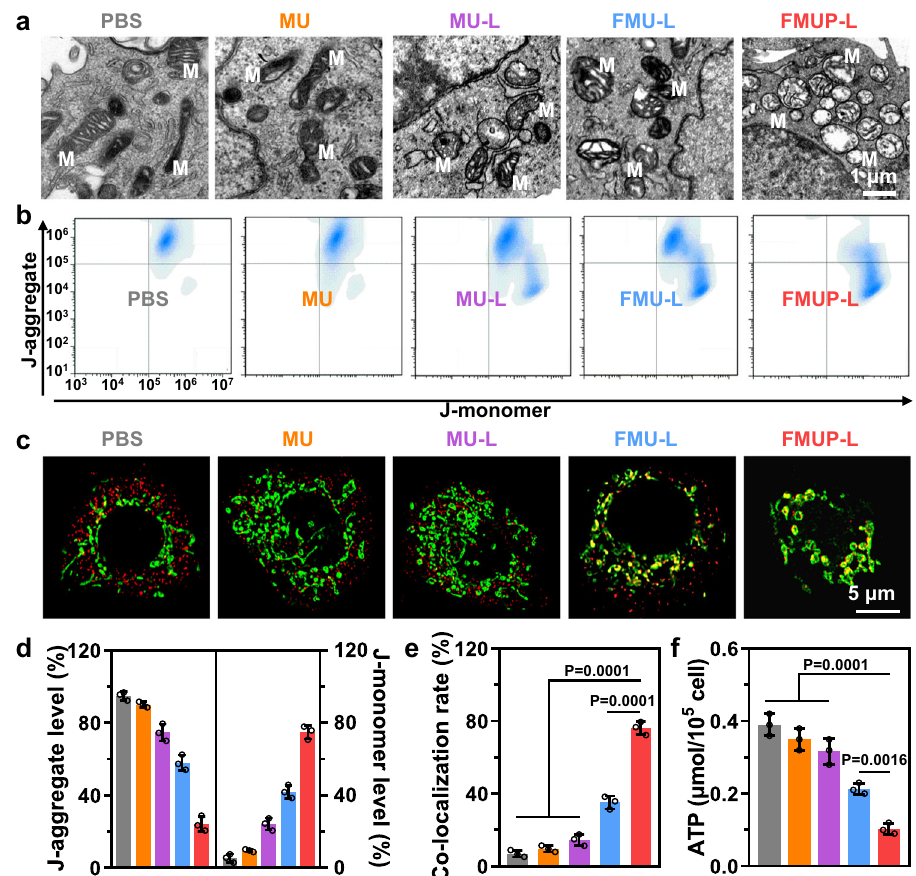
Fig. 4 In vitro evaluation of mitochondrial damage by the synergism of CDT and photoacidi fi cation. a TEM ultrathin sectioning images of mitochondrial integrity in different groups. M in images represents the mitochondria. b Mitochondrial membrane potential analysis of HeLa cells treated with different groups by using fl ow cytometry. c CLSM images of cyclophilin D (Cyp D) expression in HeLa cells with different groups. Green: mitochondria; Red: Cyp D. d Quantitative analysis of J-aggregate and J-monomer in various treatments. e The co-localization rate of nanoagents with mitochondria in different groups. f Quantitative analysis of intracellular ATP concentration in various treatments. Data in ( d – f ) were represented as mean values ± SD, n = 3 biologically independent samples in ( d – f ). A representative image of three biologically independent samples from each group is shown in ( a – c ). P values were calculated by using one-way ANOVA. in ( e , f Fig. 6a show, after intravenous injection, the majority of the MUP signals were rapidly enriched in the liver, with a minority of the MUP signals accumulating in the tumor site. In contrast, the fl uorescence signal of FMUP at the tumor site increased sub- stantially at the expense of the signal in the liver over time, indicating the pivotal role of doped FA for tumor accumulation.